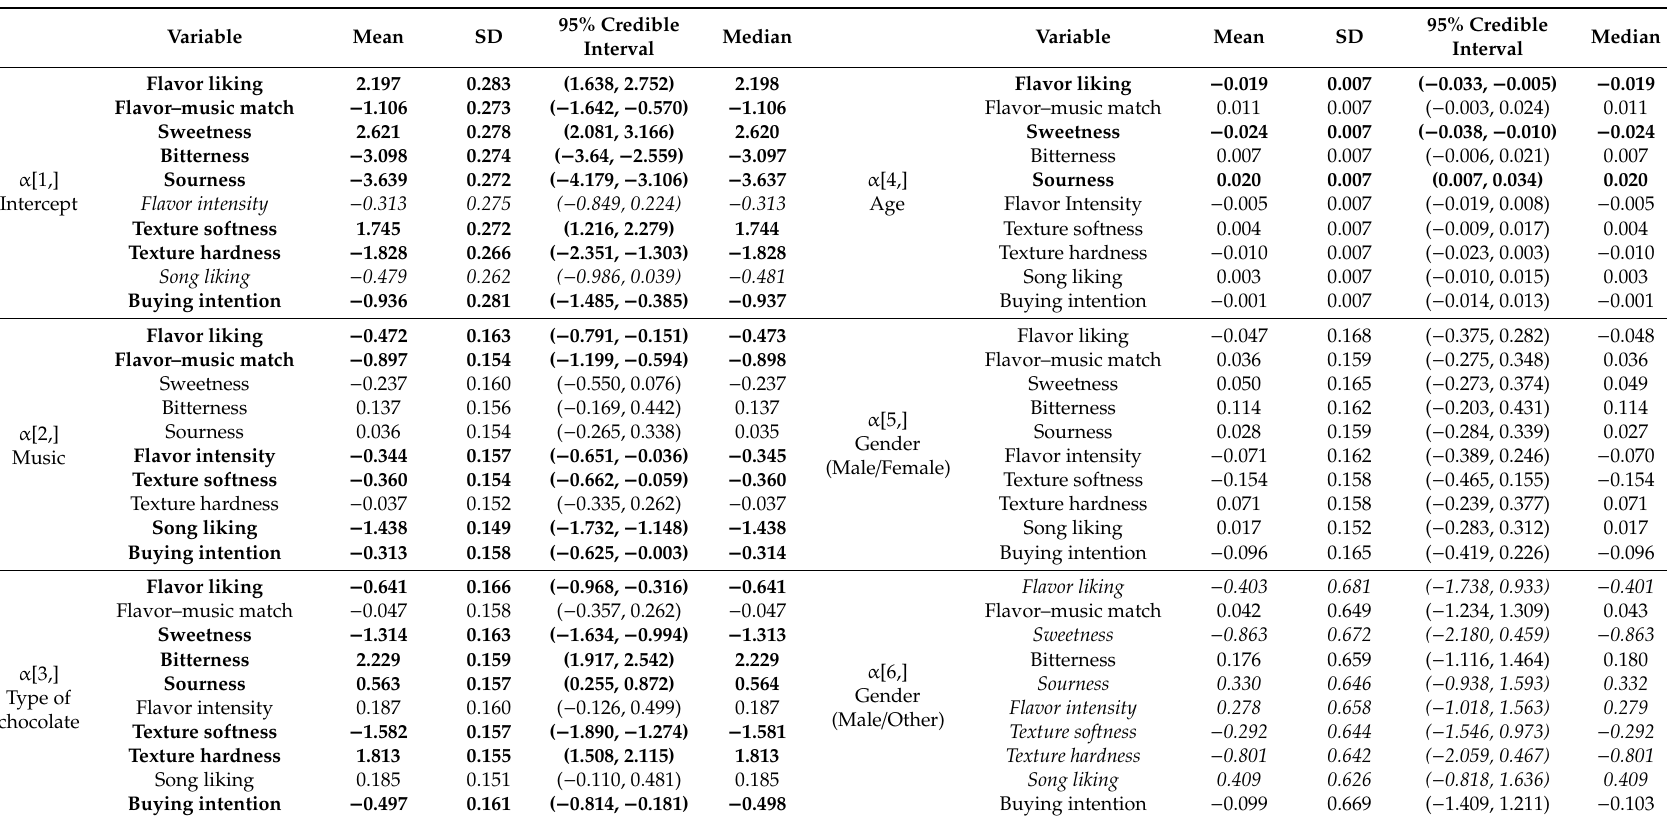
Table 3. Posterior means, posterior standard deviations, 95% credible intervals, and posterior medians for all parameters in the Bayesian logit-normal cross-modally corresponding music regression model. Values highlighted in bold represent stronger evidence of associations. Values in italics constitute weaker evidence of associations. All other values represent no evidence of